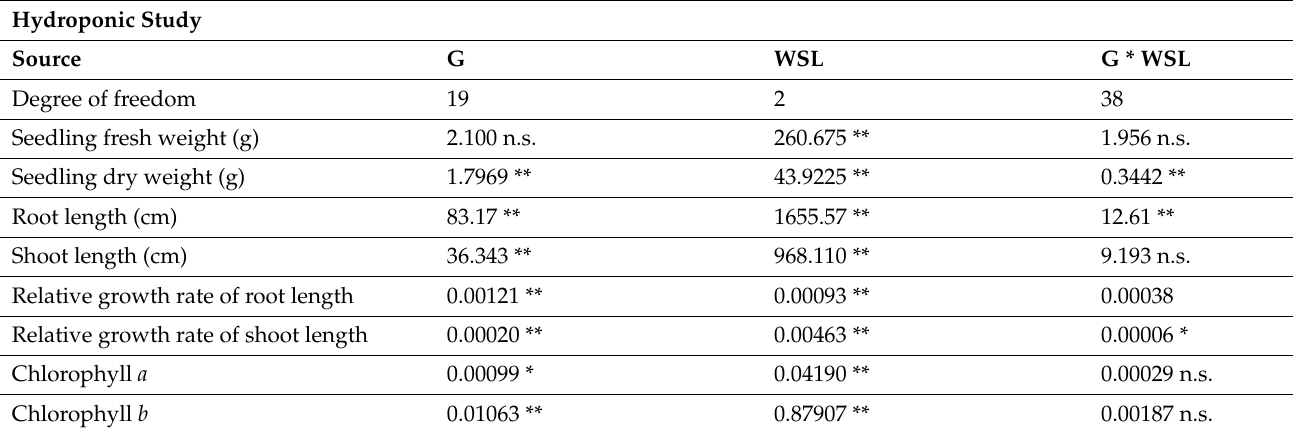
Table 3. Mean square values ( p < 0.05) for yield-related traits, growth, and physiological characteristics of quinoa genotypes under varying water-deficit conditions both in hydroponic and pot